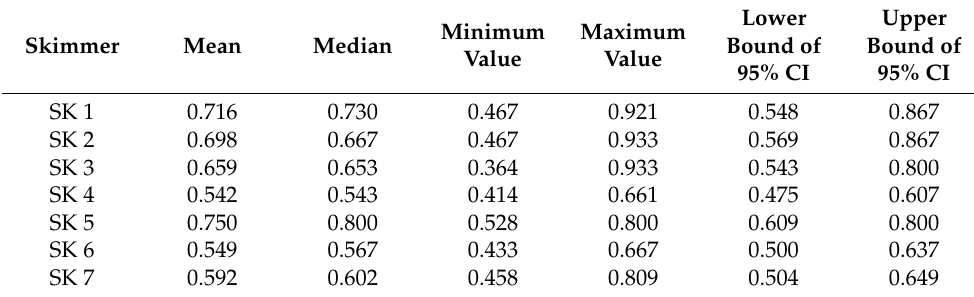
Table 4. Statistics of skimmer feasibility for offshore oil spill response in Zone